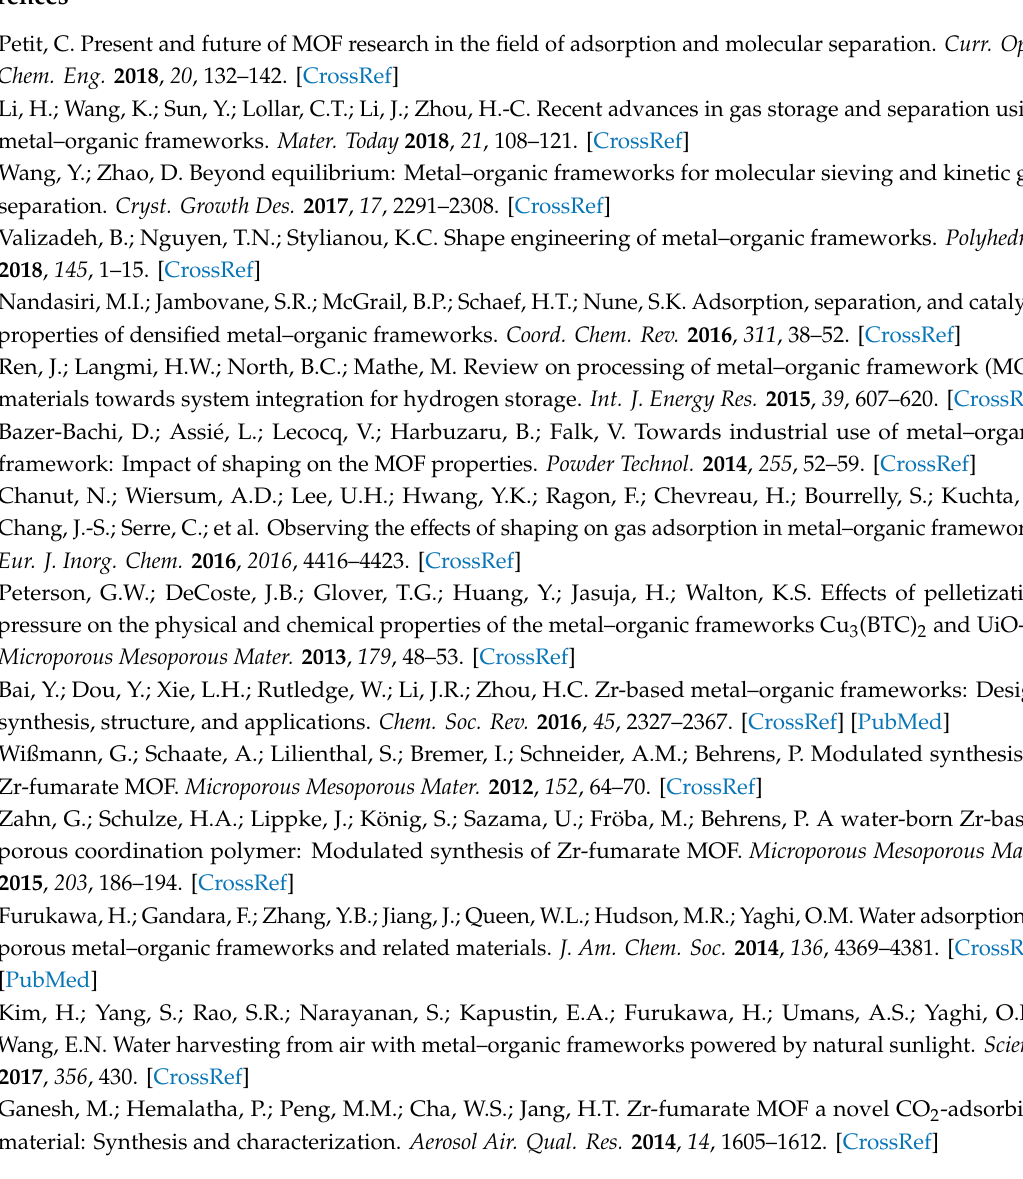
Figure S1: PXRD pattern for pellet prepared using pre-evacuated MOF-801; Figures S2–S5: Photographs of pellets after drop tests; Figures S6 and S7: Control cyclic H 2 O adsorption